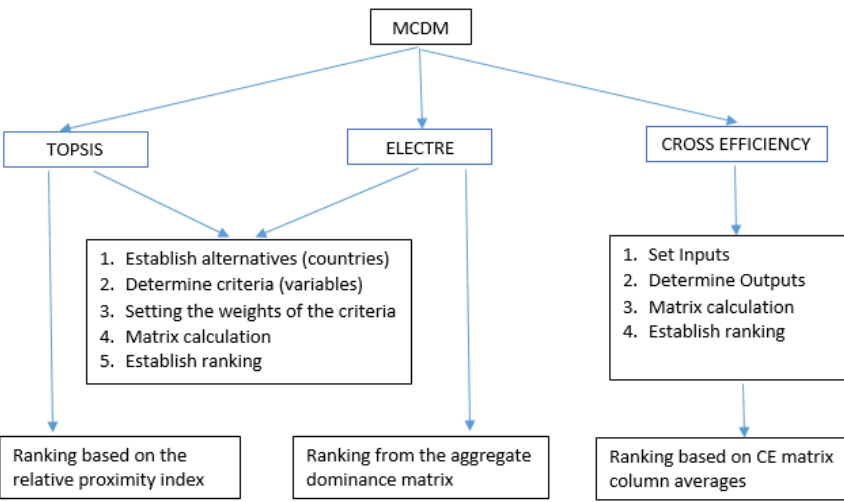
Figure 1. Diagram of multicriteria techniques. Source: Authors’ elaboration.